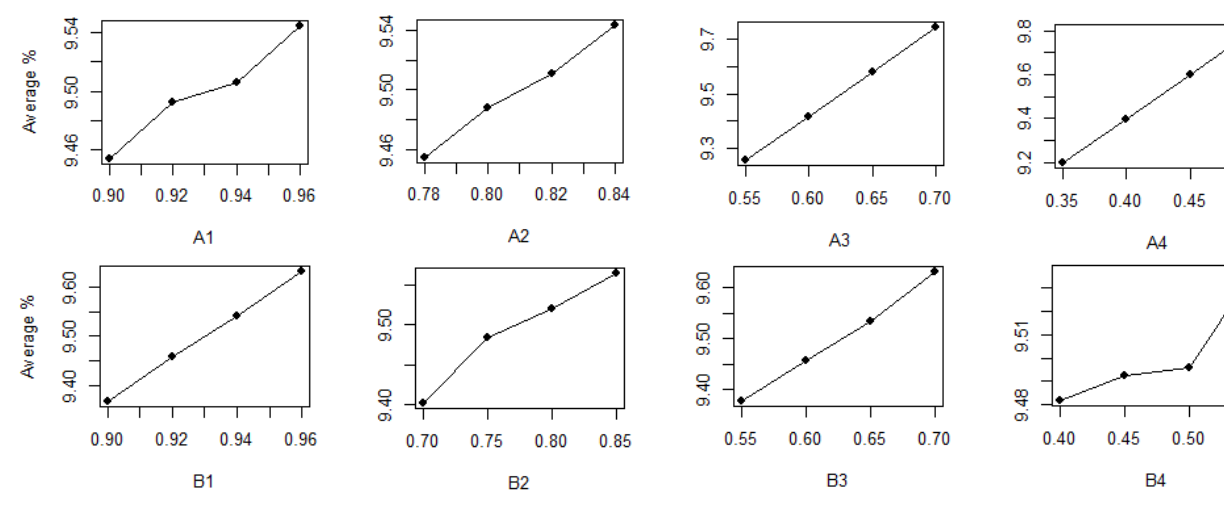
Figure 2. Effect of A and B factors on ASPS.